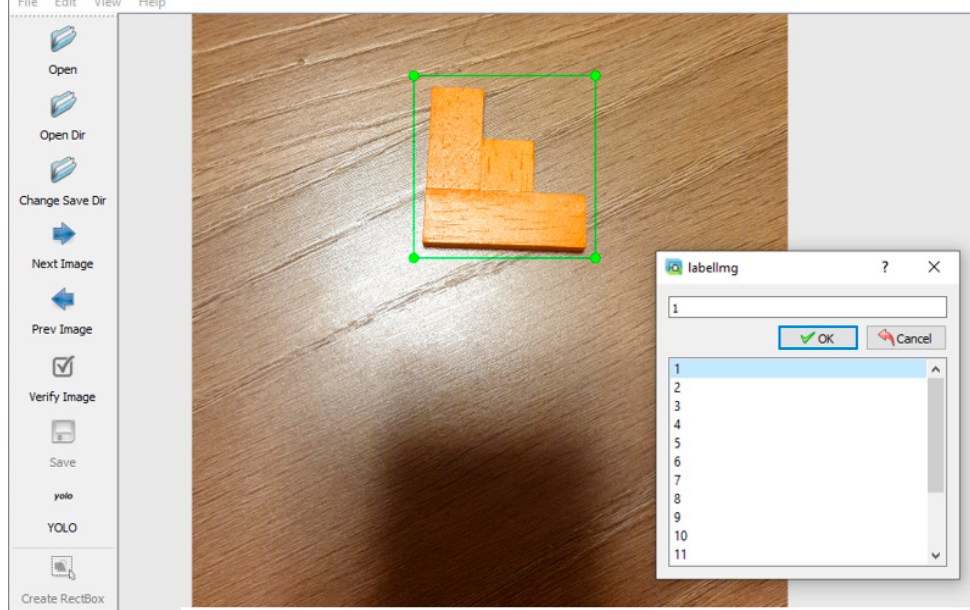
Figure 8. Object labelling using LabelImg tool.